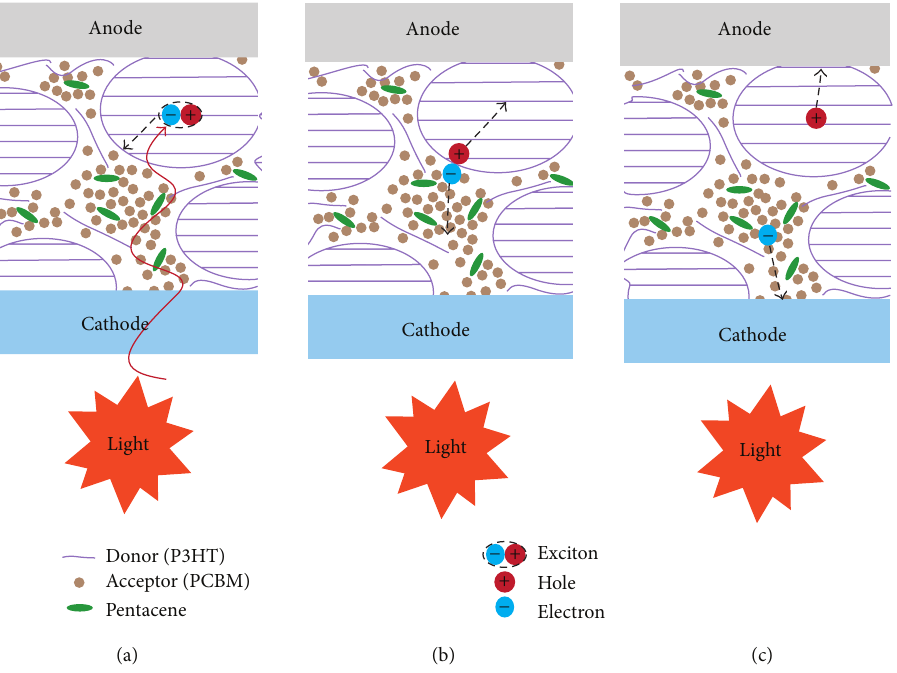
Figure 4: Schematics of photocurrent generation in P3HT: PCBM: pentacene